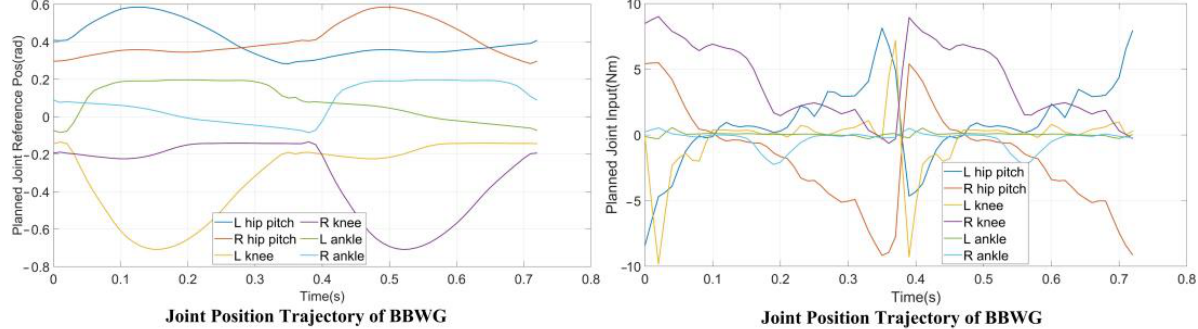
Figure 4. Planned symmetrical joint-level trajectories. In the left diagram, significant symmetry can be found and all the trajectories are within the kinematic limits. Reference joint inputs are shown in the right which the max torque is 9.8 Nm.